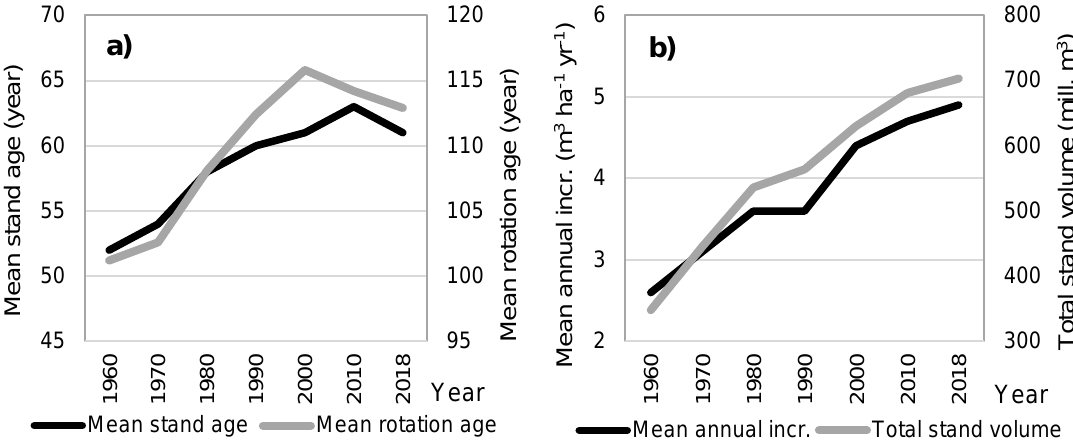
Figure 2. Development of ( a ) mean stand age and mean rotation age of forests and ( b ) mean annual timber increment and total stand volume in the Czech Republic.